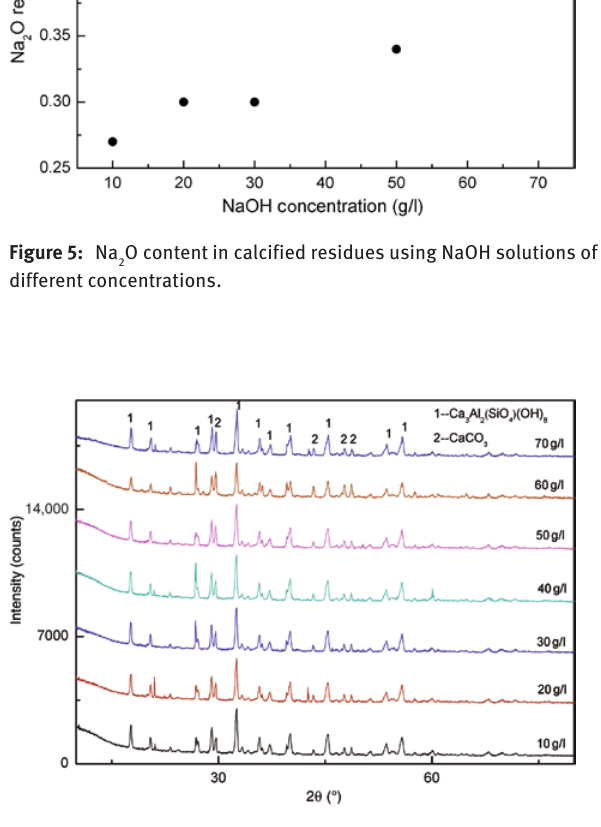
Figure 6: X-ray diffractograms of calcified residues produced from NaOH solutions of different concentrations.